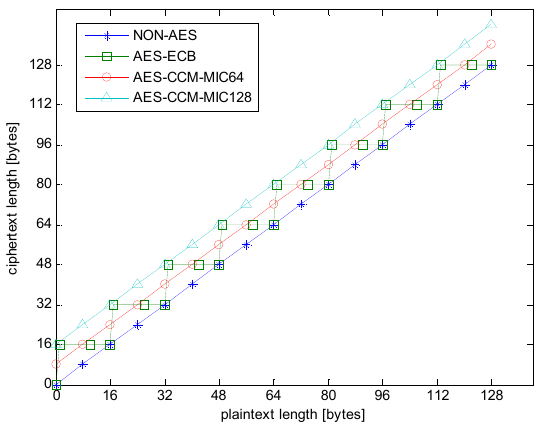
Figure 4. Change in payload length after encryption.